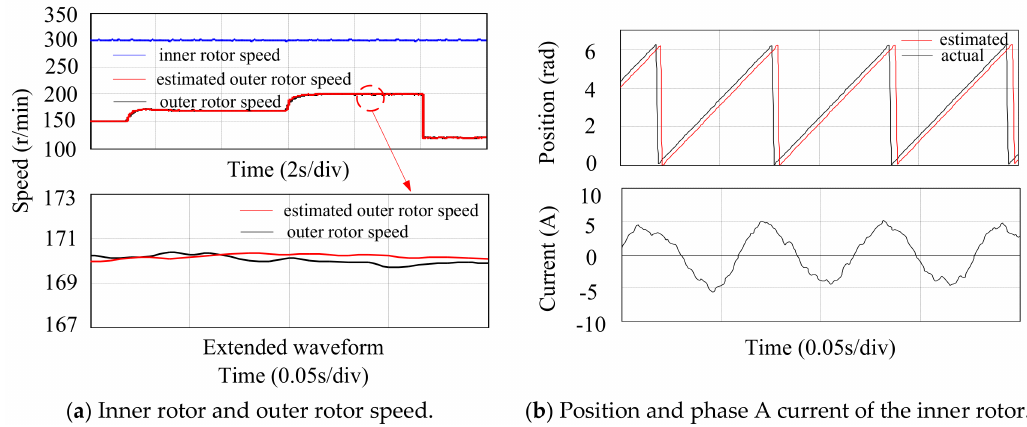
Figure 15. Experimental results of the sensorless control for